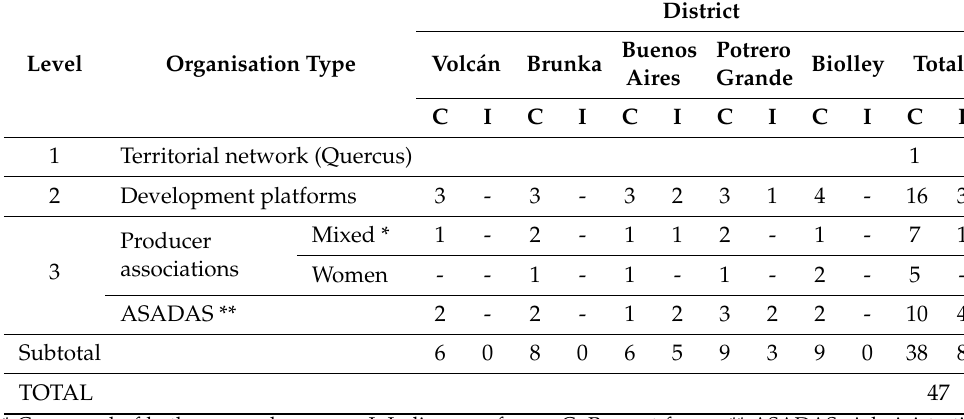
Table 4. The platform of the community base